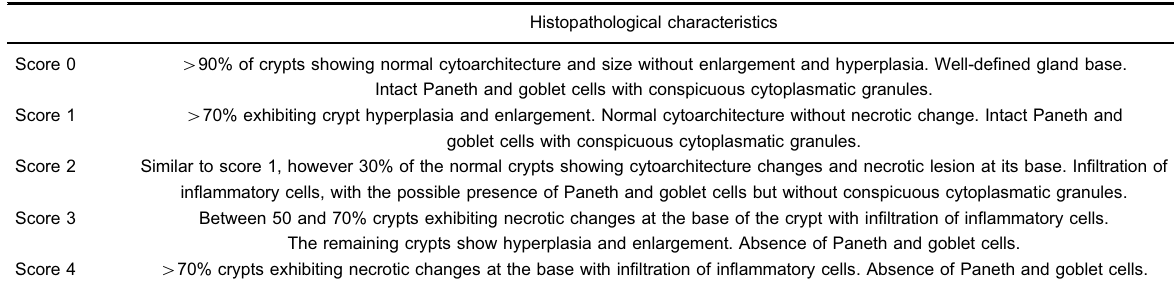
Table 1. Criteria used for the evaluation and scoring of intestinal